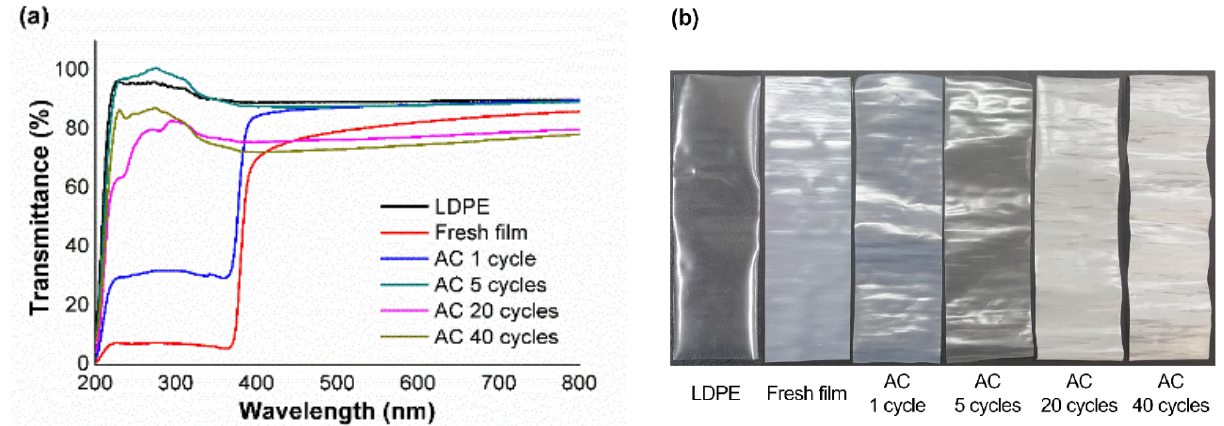
Figure 6. UV–Vis spectra ( a ) and digital photographs ( b ) of fresh film and LDPE-ZnO nanocomposite films treated with AC after different number of test cycles.